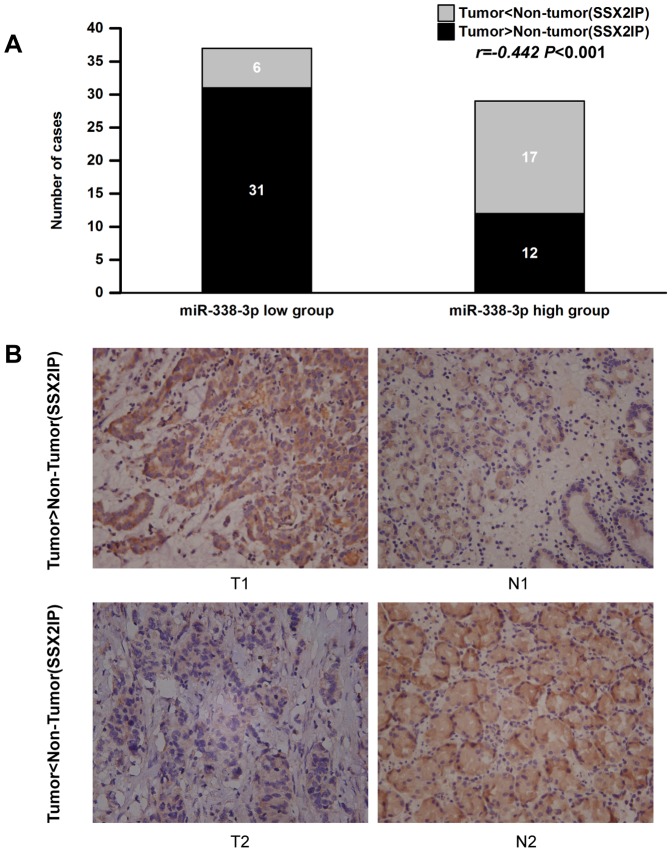
miR-338-3p expression correlates inversely with SSX2IP protein expression in gastric cancer.(A) Immunohistochemical analysis showed that increased expression of SSX2IP was more frequently observed in gastric cancer tissues in miR-338-3p low-expression group and vice versa. Tumor>Non-tumor (SSX2IP) means overexpression of SSX2IP in GC tumor tissue compared with matched non-tumor tissue, and vice versa. (B) Representative photographs of immunohistochemical analysis of SSX2IP in paired GC tumor/non-tumor tissues (magnification, 200×).